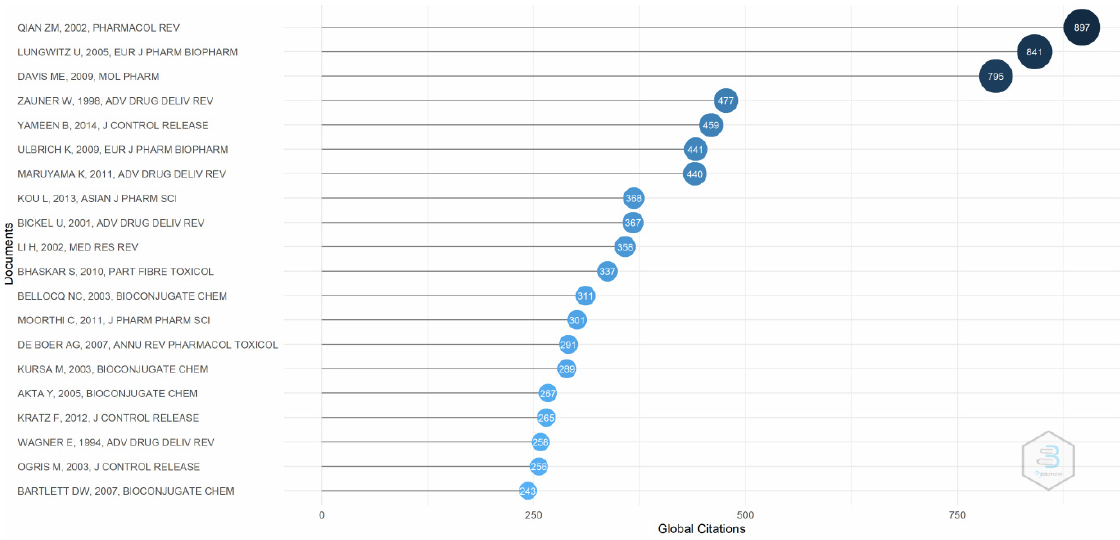
Figure 2. Annual scientific publications relating to transferrin/transferrin receptor-mediated drug delivery. Source: Authors’ elaboration using the Bibliometrix R-package.